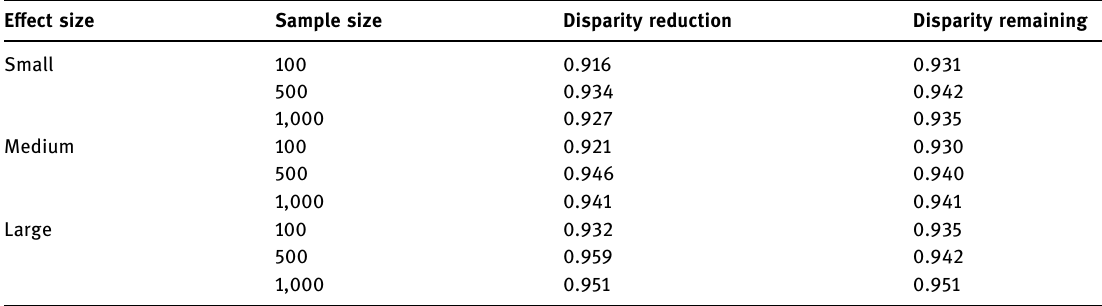
Table A1: Simulation results: 95% CI coverage rates of the standard error estimators of disparity reduction and remaining E ff ect